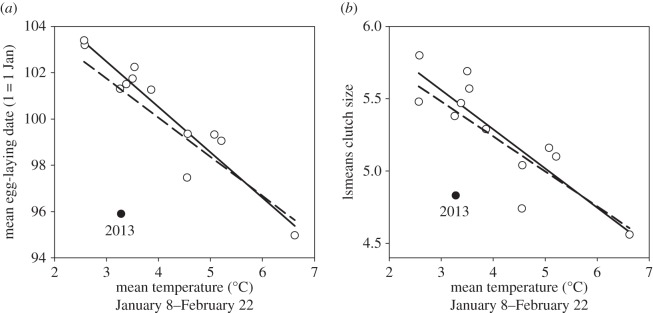
Relationship between mean temperature (°C) for the sliding window period 8 January–22 February and (a) mean egg-laying date and (b) least-squares means (lsmeans) clutch size (corrected for laying date) for 2002–2013. Regression lines are fitted to data with (solid line) and without 2013 (dashed line).